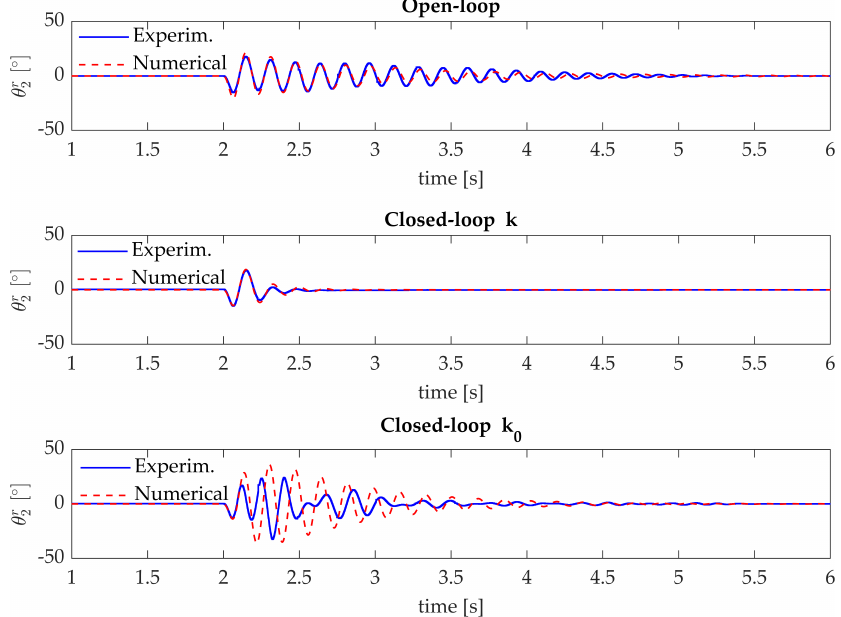
Figure 11. Test case 1: comparison of the numerical and experimental open-loop and closed-loop impulse responses.